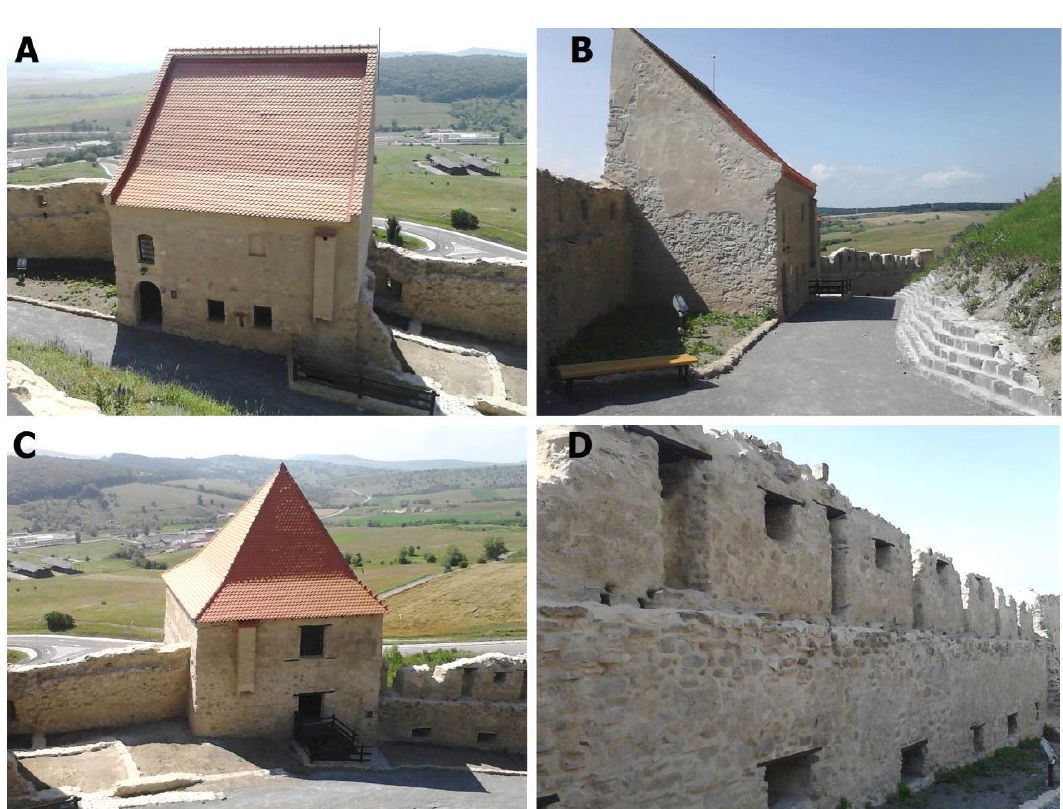
Figure 6: View over A, B – The Chapel, C – The Gresbig Tower or Scouts’ Tower and D – details on the wall between The Gresbig Tower and The Middle Fortress Gate after rehabilitation